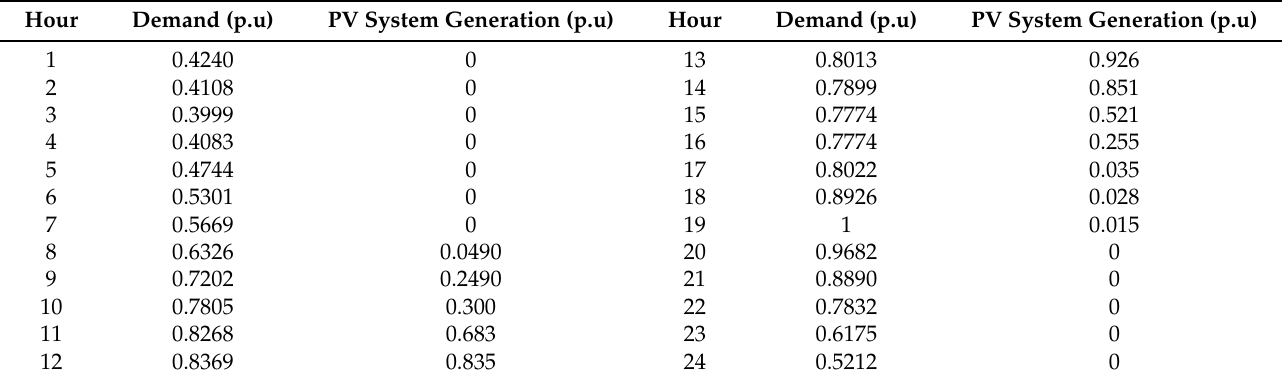
Table 2. Characteristic data of demand and generation of a PV system.